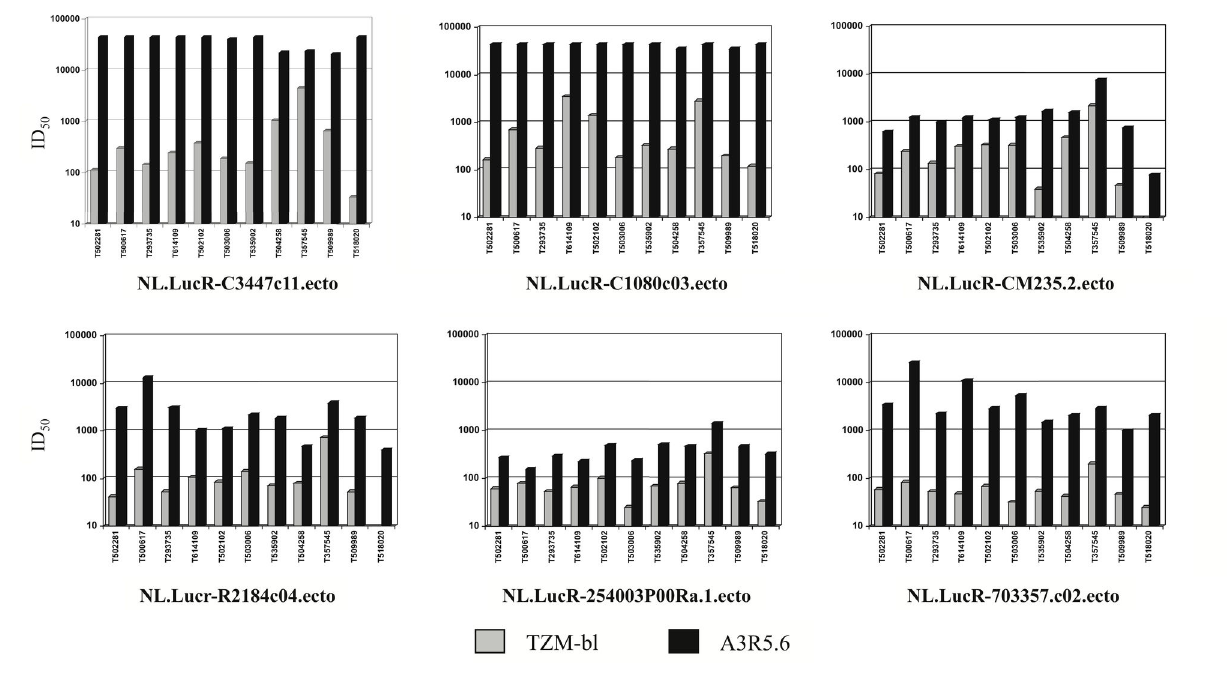
Figure 5. Comparison of neutralization sensitivity in A3R5 and TZM-bl cell lines. A panel of eleven HIV+ CRF_01 AE sera was assayed against two tier 1 (C3347.c11 and C1080.c03) and four tier 2 (CM235-2, R2184.c04, 254003P00Ra.1 and 703357.c02) CRR_01 AE Env.IMC.LucR viruses in the A3R5.6 and TZM-bl cell lines. ID50 titers are the dilution of serum at which the Renilla luciferase signal was reduced by 50% compared to the virus control (no serum). Neutralization sensitivity was significantly greater (p<0.001; Wilcoxon Rank Sum) in the A3R5 cell line compared to TZM-bl for all virus/sera pairs tested. Similar results were obtained with the A3R5.7 cell